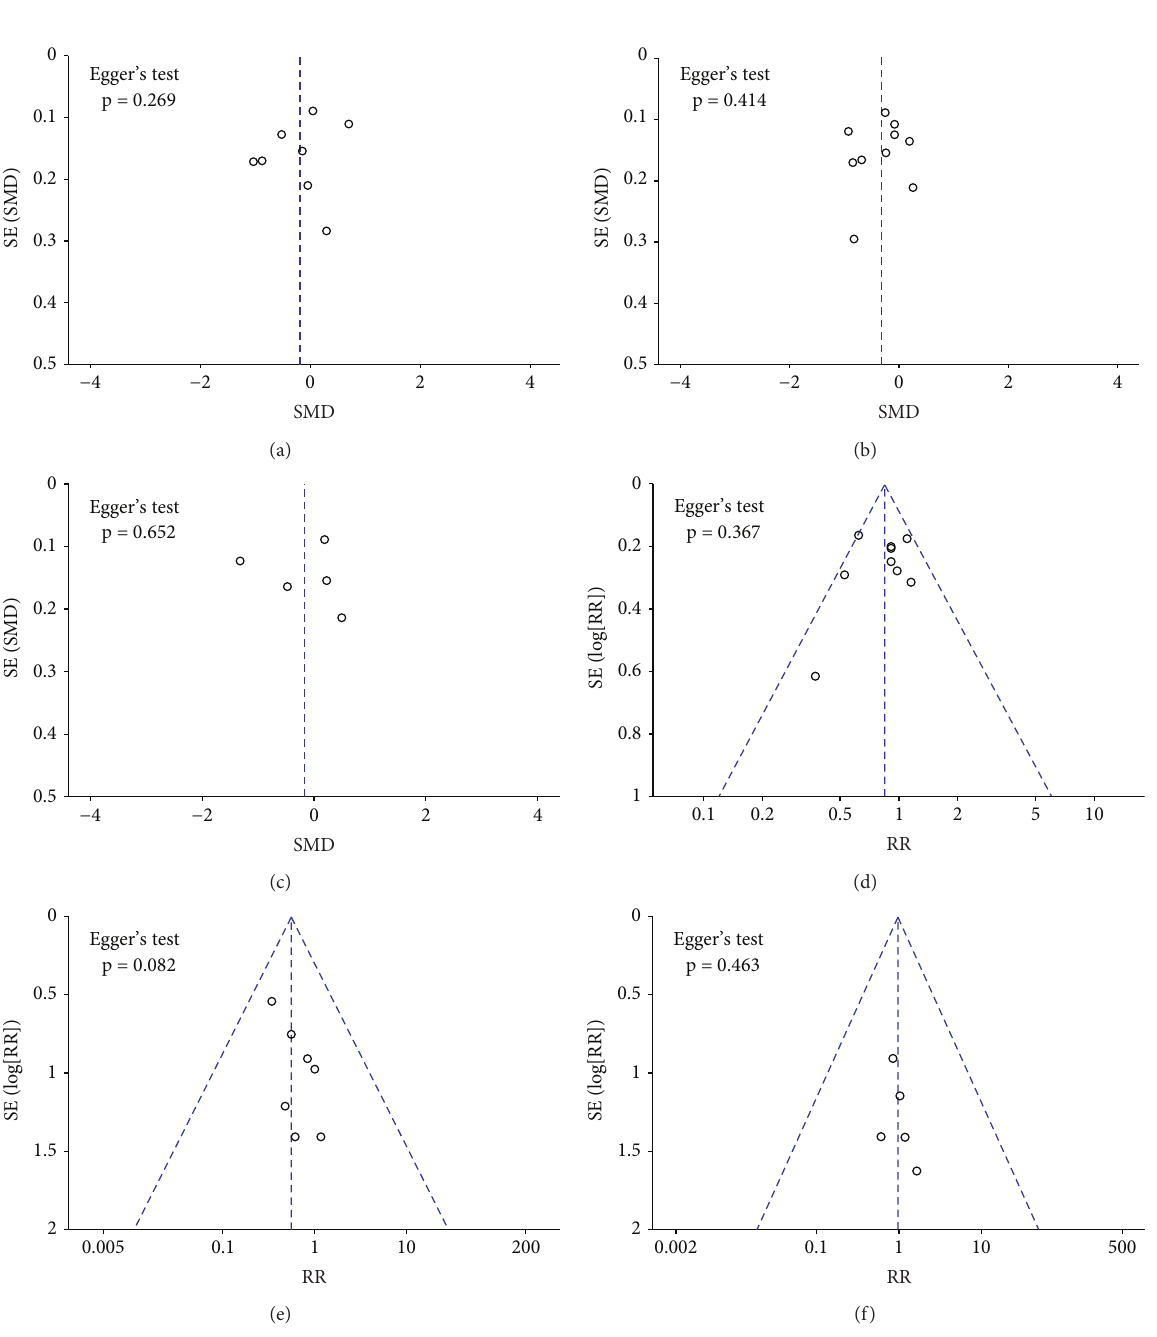
Figure 4: Funnel plots and Egger’s test were used to assess publication bias of (a) mean procedural time, (b) mean ablation time, (c) mean fluoroscopy time, (d) postoperative recurrence rate, (e) total complication rate, and (f) incidence of serious adverse